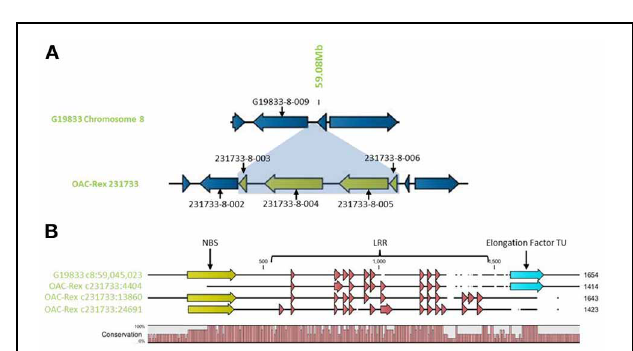
FIGURE 8 | Dendrogram of relationships among Niemann Pick and 7 transmembrane receptor (7TMR) proteins from P. vulgaris , M. truncatula , and A. thaliana . The dendrogram was constructed with CLCGenomics Workbench v. 5.0. Numbers indicate the bootstrap value for each node.